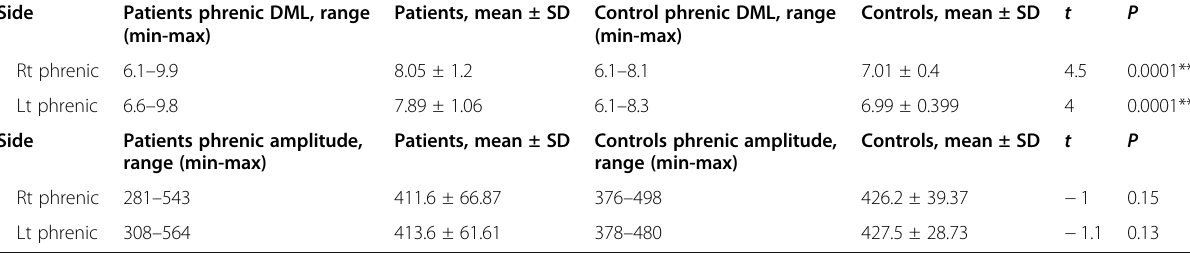
Table 1 Comparison between patients and controls regarding electrophysiological data Side Patients phrenic DML, range Patients, mean ± SD Control phrenic DML, range Controls, mean ± SD t (min-max) (min-max) Rt phrenic 6.1 – 9.9 Side Patients phrenic amplitude, Patients, mean ± SD Controls phrenic amplitude, range (min-max) range